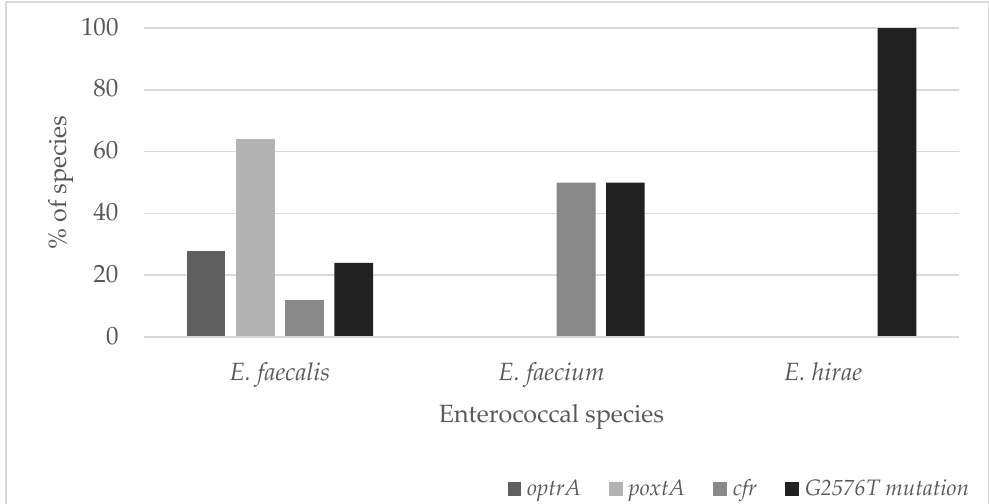
Figure 1. The genetic background of linezolid-resistant (LZD R ) Enterococcus strains analyzed in this study.